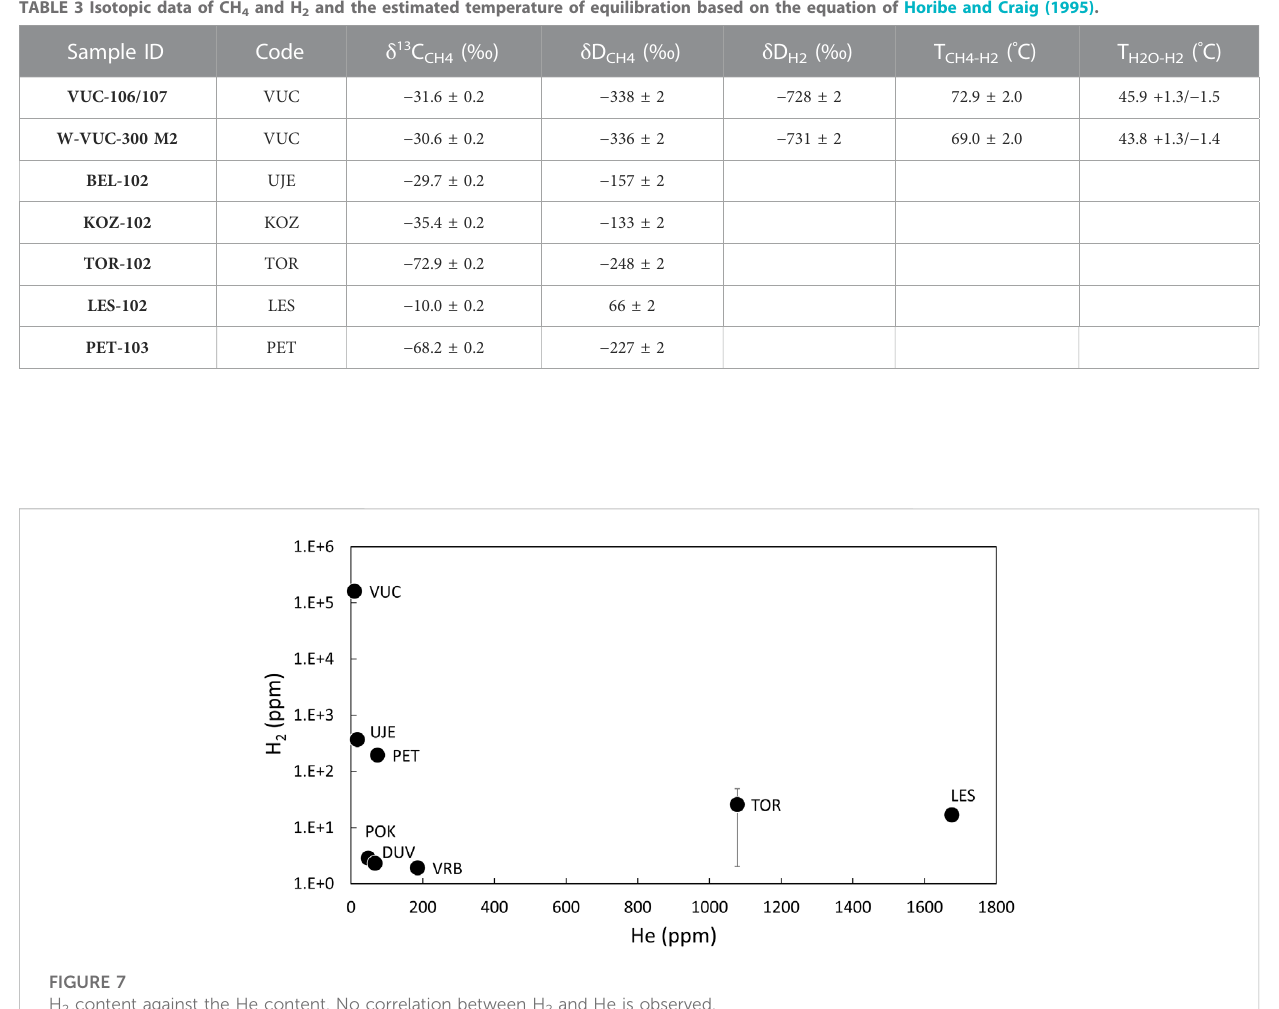
H 2 content against the He content. No correlation between H 2 and He is observed.